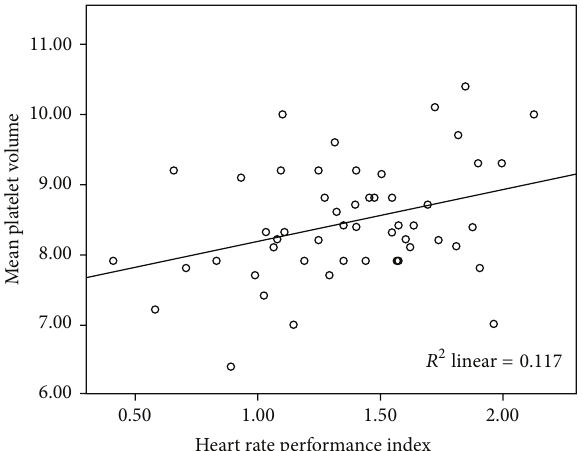
Figure 2: No significant correlation was seen between heart rate performance index and mean platelet volume in controls ( 𝑟 = 0.239 , 𝑃 = 0.204 ).